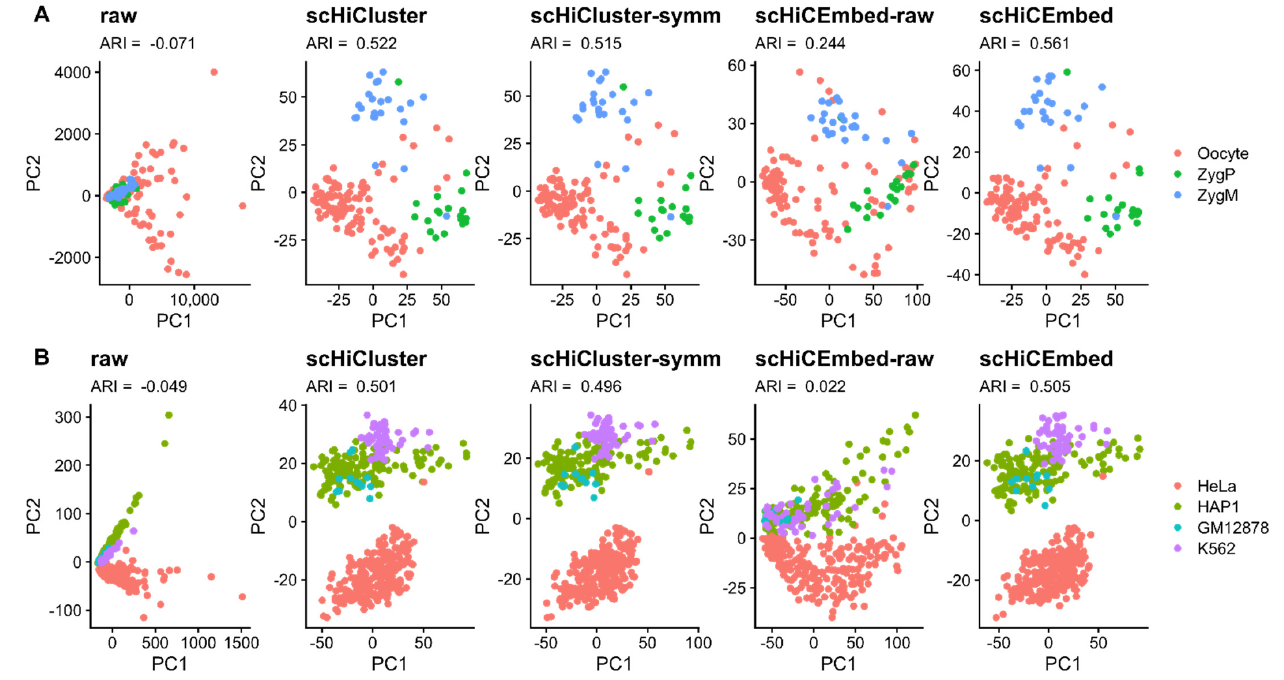
Figure 2. Results for cell type clustering (PC1 vs. PC2) on data sets 1 ( A ) and 2 ( B ) at 1 Mb resolution for raw single-cell Hi-C and imputed Hi-C from four methods, including scHiCluster, scHiCluster- symm, scHiCEmbed ‐ raw, and scHiCEmbed.